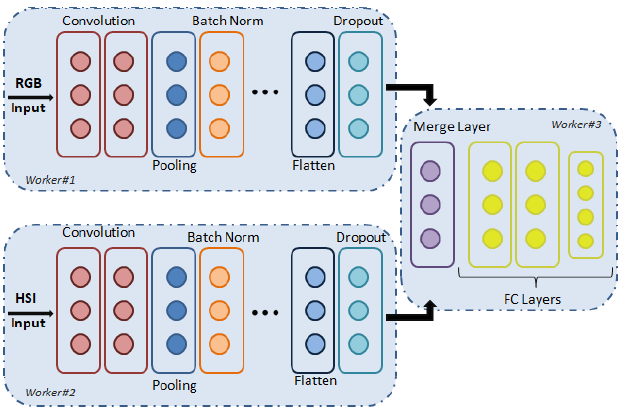
Figure 4. The baseline architecture of proposed distributed multimodal CNN consists of three main parts, each assigned to a different worker: The VHR-RGB part at the top branch, the HSI part at the bottom branch and merging part that leads to classification output is shown on the